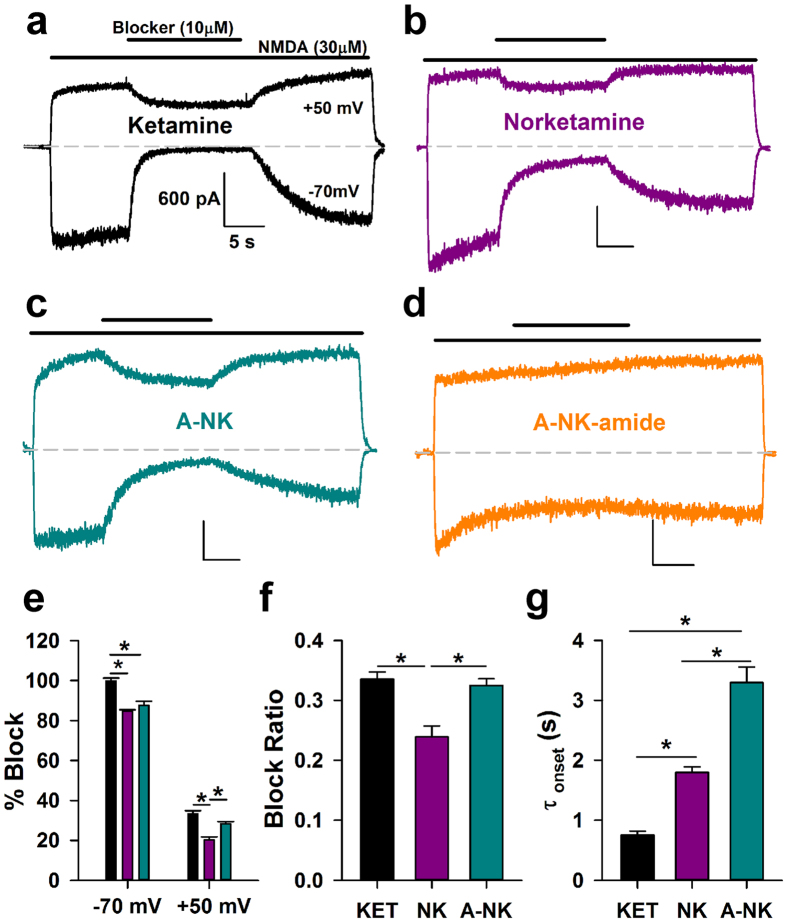
Ketamine, norketamine and A-NK are NMDAR antagonists.(a–d) Representative traces depicting block and wash off at −70 mV and +50 mV for 10 μM ketamine (a), 10 μM norketamine (b), 10 μM A-NK (c), and 10 μM A-NK-amide (d). Calibration bar values in (a) correspond to all 4 panels. All the compounds, save A-NK-amide, were active. (e) Inhibition achieved near steady-state for the active compounds was calculated. At −70 mV and at +50 mV, both norketamine and A-NK were significantly different than ketamine, but at +50 mV, norketamine exhibited significantly less block than the two compounds (n = 4–5, *p < 0.05, t-test Bonferroni correction for multiple comparisons). (f) The inhibition at +50 mV was divided into the block achieved at −70 mV to calculate a “block ratio” for all active compounds. This measure of voltage-sensitivity was significantly lower for norketamine compared to the two other compounds (n = 4–5 *p < 0.05, t-test Bonferroni correction for multiple comparisons). (g) The rate of block onset at −70 mV was measured for all three active compounds. Norketamine exhibited significantly slower onset kinetics than ketamine, and A-NK displayed slower kinetics than both ketamine and norketamine (n = 4–5, *p < 0.05, t-test with Bonferroni correction for multiple comparisons).